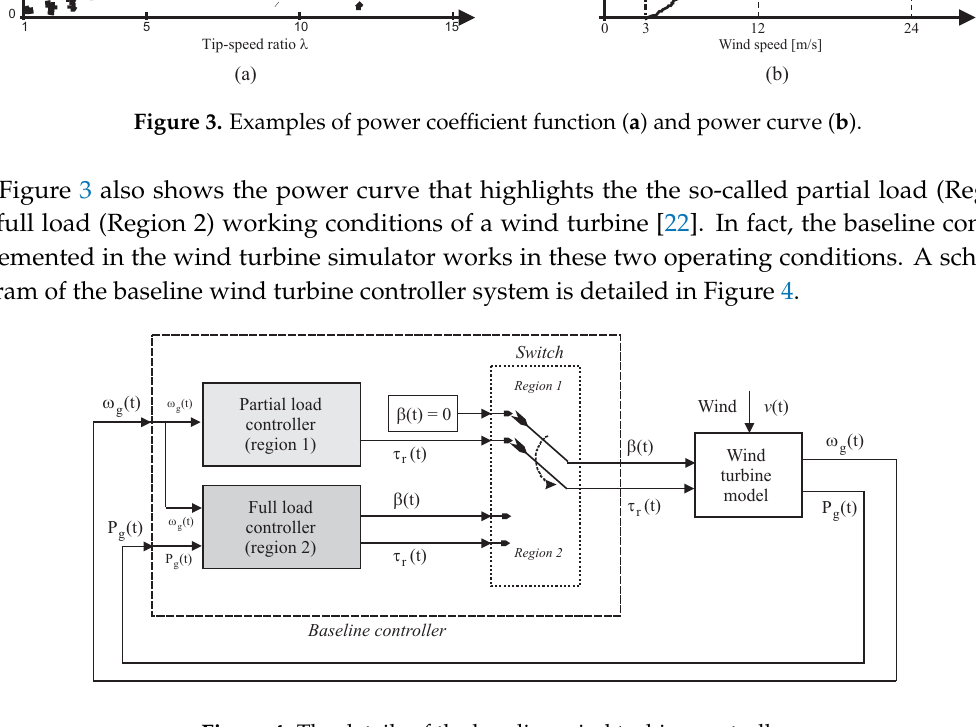
Figure 4. The details of the baseline wind turbine